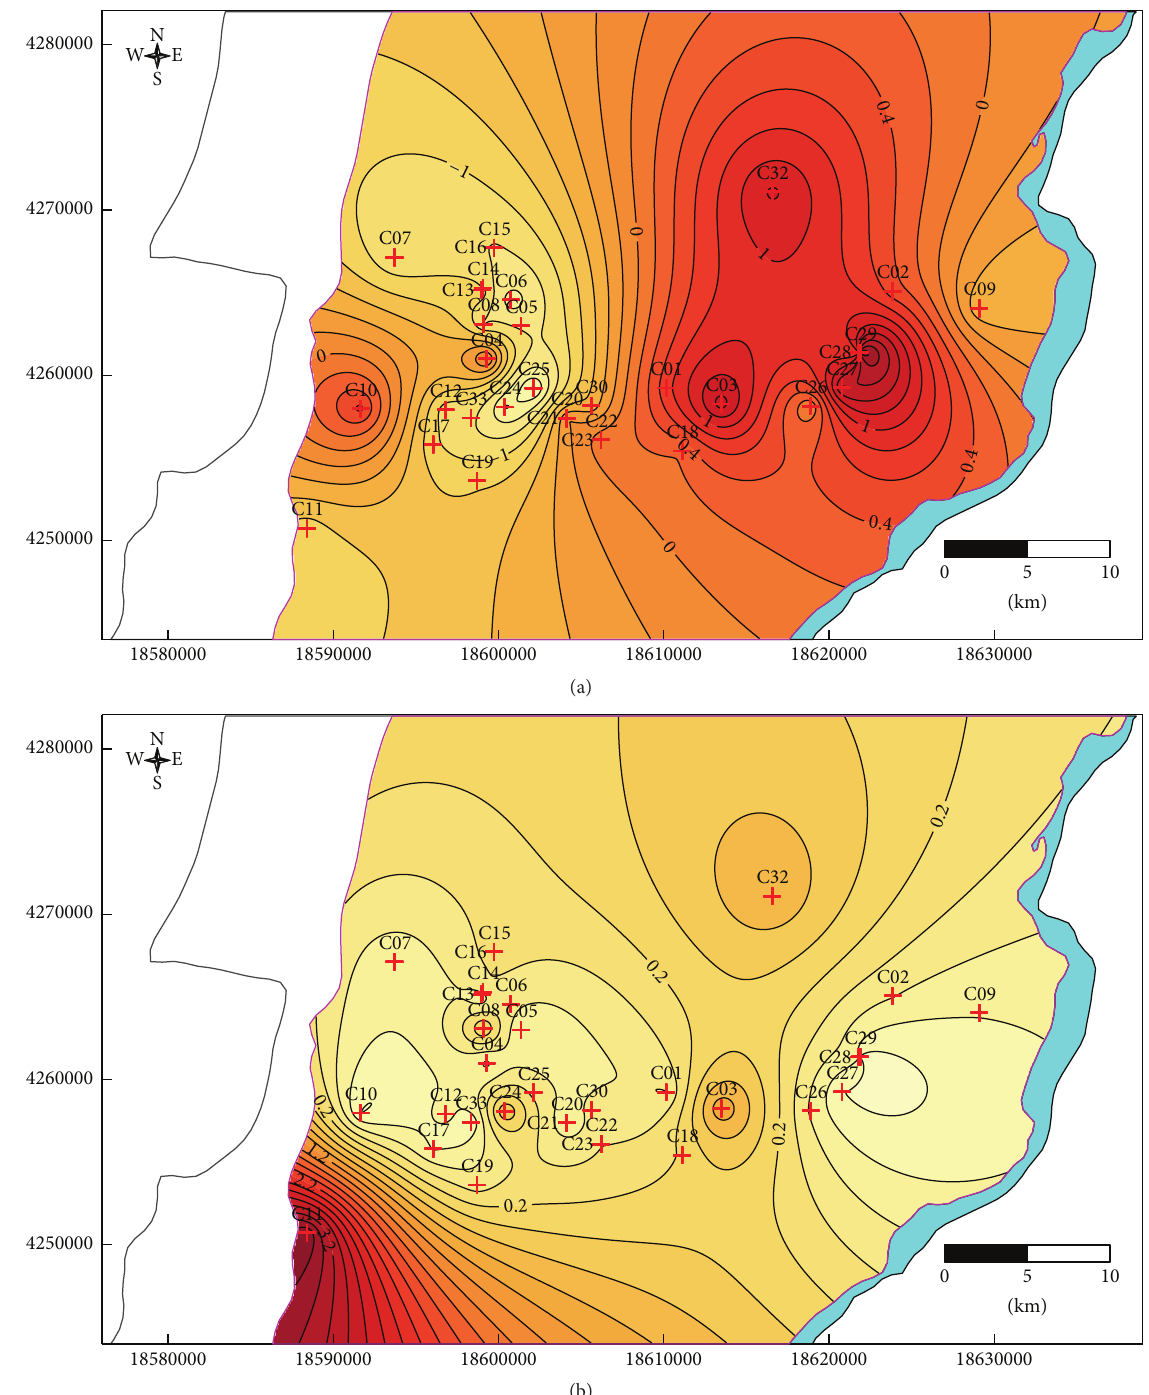
Figure 9: Spatial distribution of sampling stations by (a) VF1 scores and (b) VF2